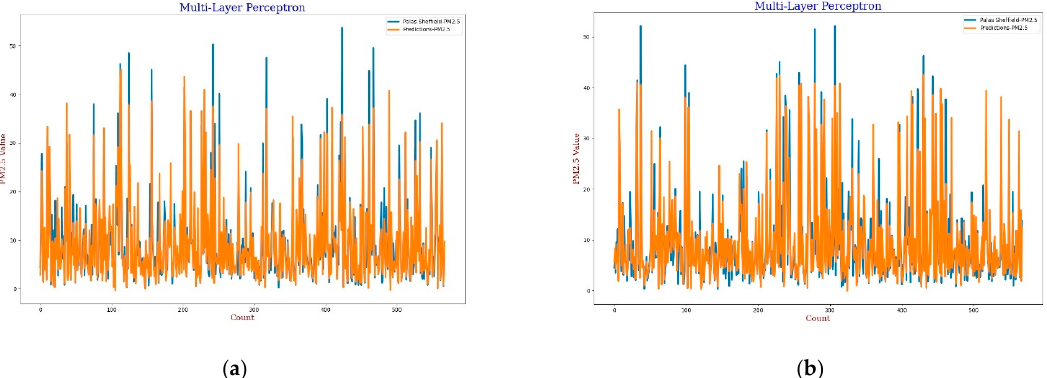
Figure 9. ( a ) MLP calibration plot for PM 2.5 using AH . Blue colour represents the reference data and orange colour represents the calibrated data; ( b ) MLP calibration plot for PM 2.5 using RH . Blue colour represents the reference data and orange colour represents the calibrated data.